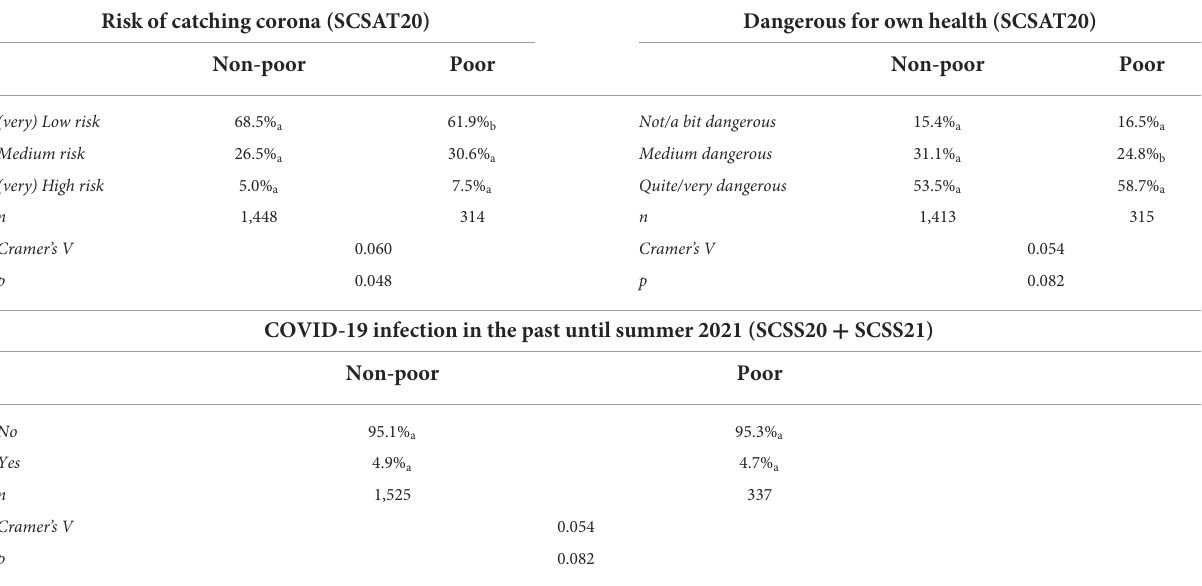
TABLE 2 Perception of and experience with the coronavirus.